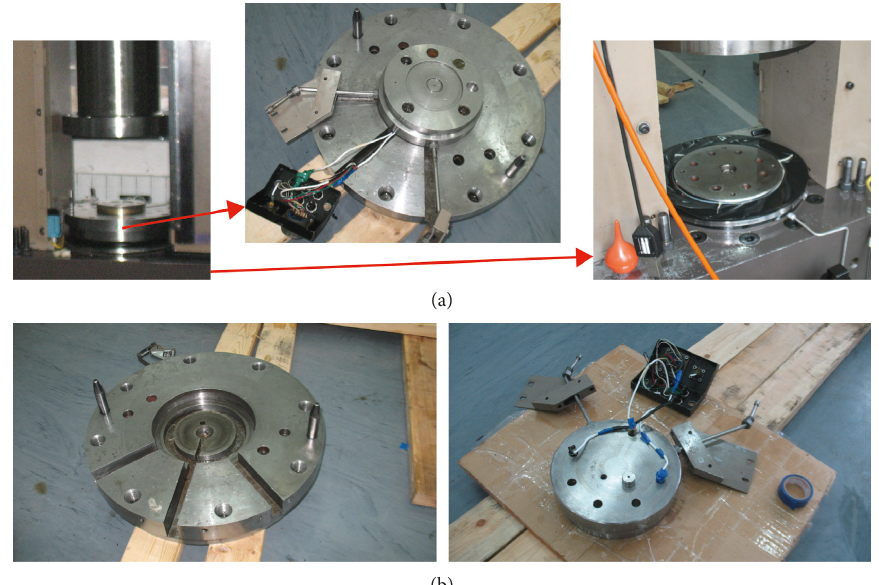
Figure 6: The breakdown diagram of the pressure base and the communication base of the test system: (a) test base decomposition and (b) communication base dismantling.